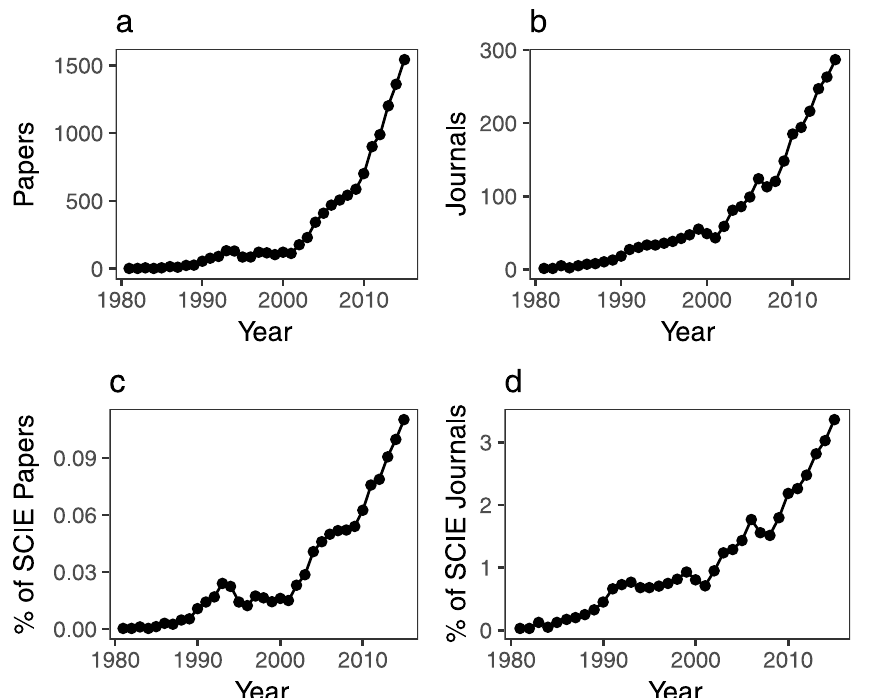
Fig 1. Number of papers (a) and journals (b) that publish ALD research, and percentage among SCIE papers (c) and journals (d).